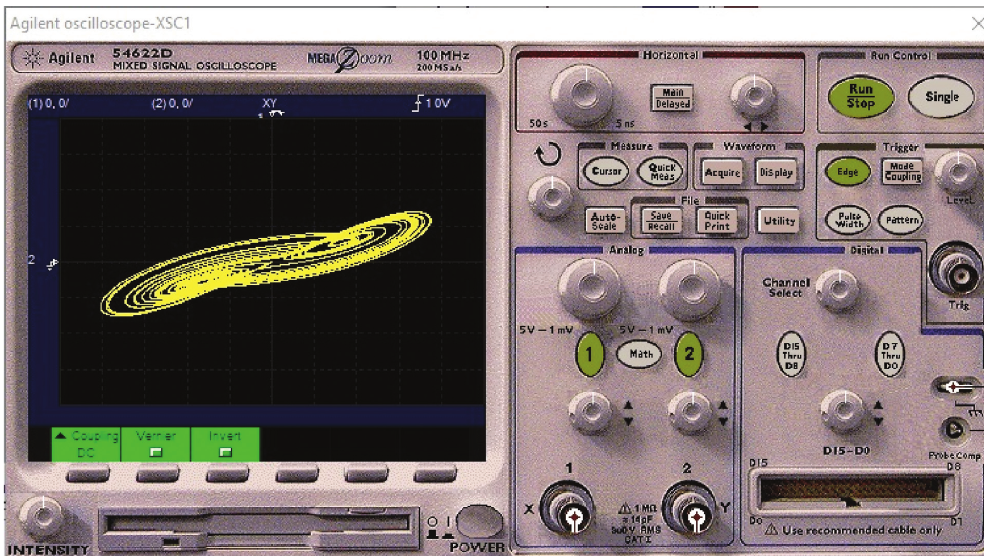
Figure 6: Phase portrait of the state variable x